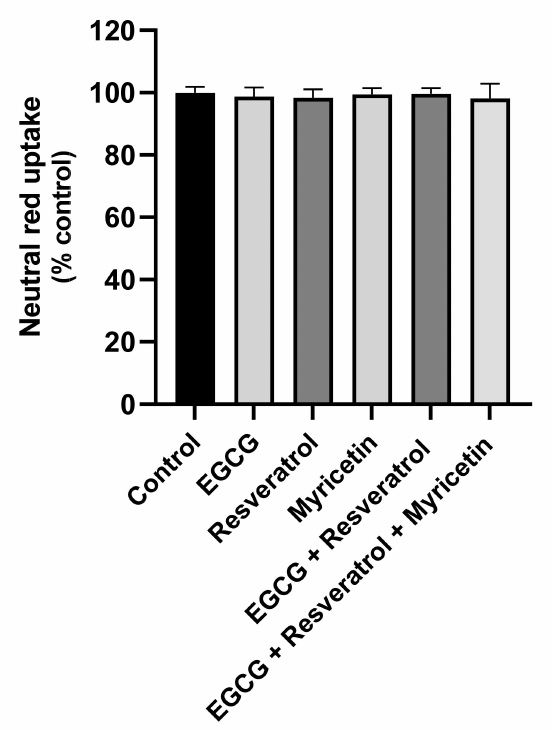
Figure 6. Cytotoxicity of the free drugs (alone or in combination) evaluated in HaCaT cells by the neutral red (NR) uptake assay 24 h after exposure. The compounds were only evaluated at the 0.81 µ g/mL concentration, the concentration present in the 50 µ g/mL concentration of each formulation. Results are expressed as mean ± SD from 4 independent experiences, performed in triplicate. Statistical comparisons were made using one-way ANOVA followed by Dunnett’s multiple comparisons test. In all cases, p -values < 0.05 were considered